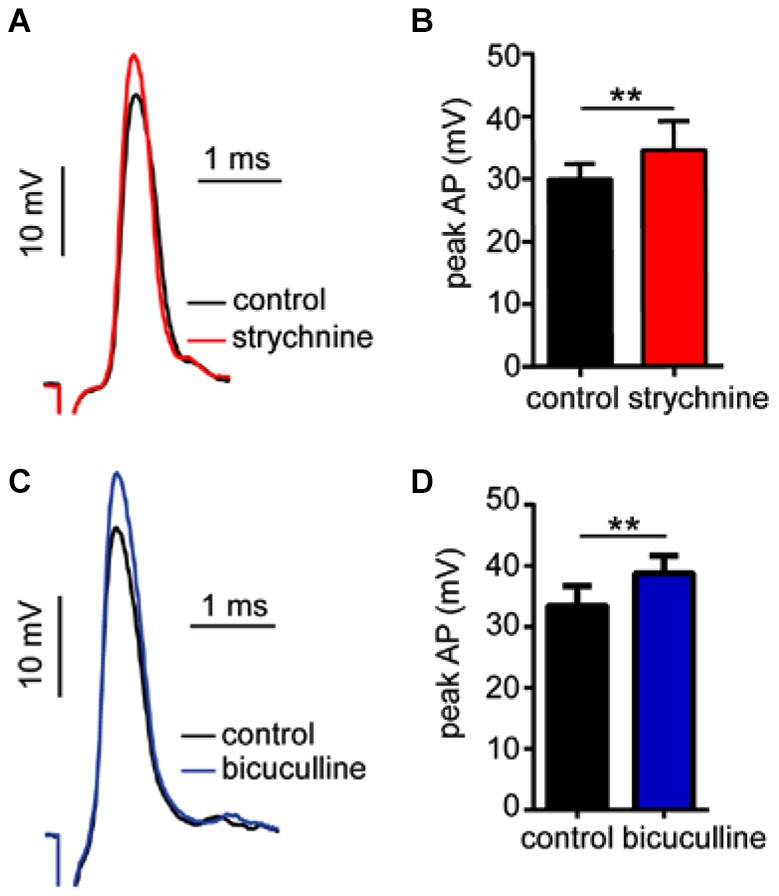
Strychnine and bicuculline increase Mauthner-cell excitability. (A) Sample recordings showing antidromically-evoked Mauthner-cell (M-cell) action-potentials (APs) in control conditions(black trace) and after treatment with strychnine (red trace, superimposed). (B) Plots of mean (± SEM) AP magnitude in control (black bar) and strychnine (red bars) treatment conditions. (C) Sample recordings of antidromically-evoked M-cell APs, in control (black trace) and bicuculline (blue trace, superimposed) treatment conditions. (D) Plots of mean (± SEM) AP magnitude in control (black bar) and bicucilline (blue bar) conditions. Asterisks indicate p values in statistical comparisons that were < 0.01 (**).